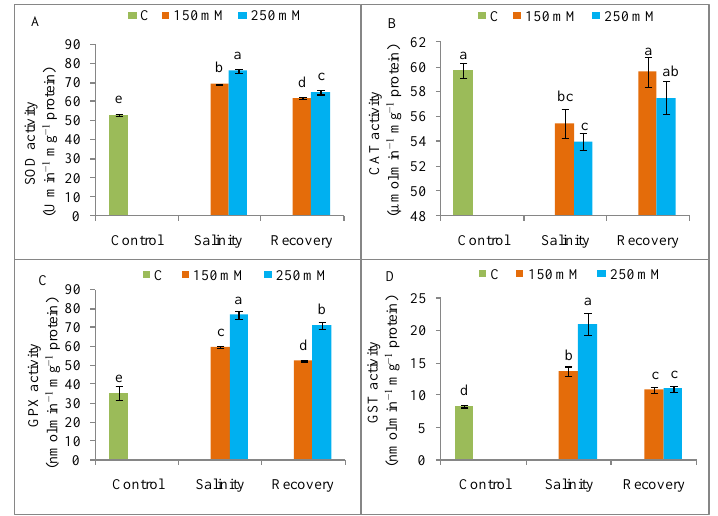
Figure 11. ( A ) Activities of superoxide dismutase (SOD), ( B ) catalase (CAT), ( C ) glutathione peroxidase (GPX), and ( D ) glutathione S -transferase (GST) in tomato plants under salinity (150 and 250 mM NaCl) and after a 48 h recovery period. Data means ( ± SD) were calculated from three replications. Statistically significant values are indicated by dissimilar letters (Fisher’s LSD test, P ≤ 0.05).